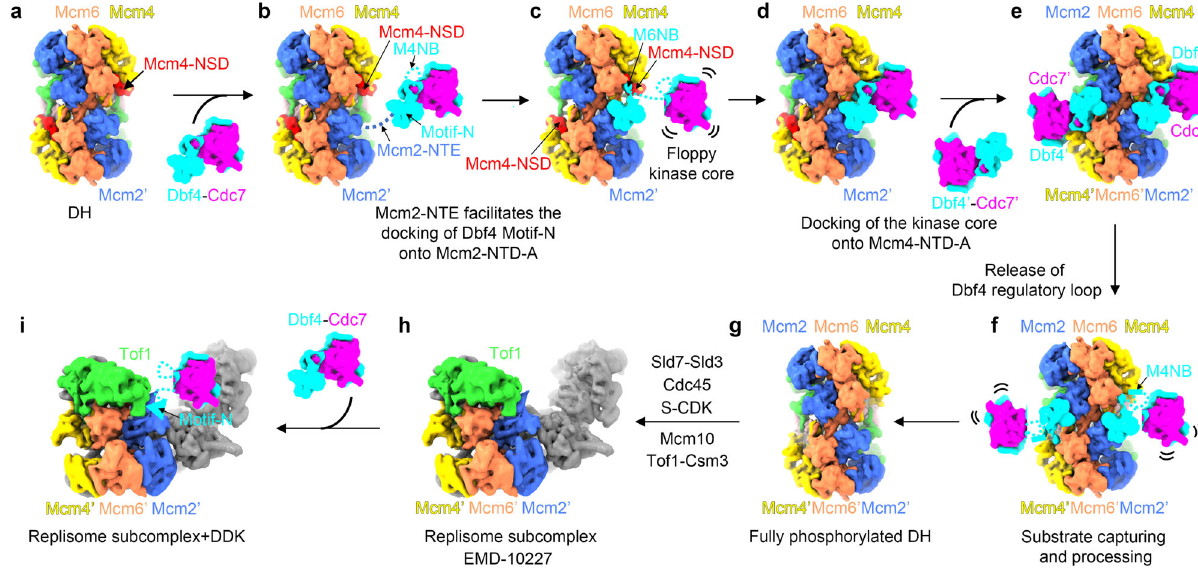
Fig. 6 Model illustrating the action of DDK on Mcm2-7 complex to regulate helicase activation and replisome activities. To summarize the high- resolution snapshots of the DH-DDK structures into a congruent series of motion frames that represent the step-by-step action of DDK on its MCM substrates. The low-pass fi ltered cryo-EM maps are used to depict DH, DDK, and replisome (EMD-10227). a Once assembled at replication origin, the DH encircles dsDNA with the NSD of Mcm4 nested on its own NTD-A to impose an inhibitory effect on helicase activation. b The unstructured NTE of Mcm2 ’ engages with motif N of Dbf4 and/or other region of DDK to facilitate the docking of motif N onto the NTD-A of Mcm2 ’ . c When motif N and M6NB of Dbf4 bind to the NTD-As of Mcm2 ’ and Mcm6 respectively, the fl oppy kinase core of DDK is positioned proximal to the NTD of Mcm4. d The kinase core is then docked onto the NTD-A of Mcm4 with the NSD of Mcm4 displaced by the M4NB of Dbf4 to be captured by Cdc7. During this docking process, the regulatory loop of Dbf4 occupies the activity center of the kinase to prevent premature substrate capturing by Cdc7. e DDK is docked onto each of the coupled MCM hexamers to function independently. f Conformational change in the kinase core and its subsequent dissociation from Mcm4 help to remove the regulatory loop of Dbf4 from Cdc7, enabling kinase center accessible to substrates. g After DDK phosphorylation, the NSD of Mcm4 becomes highly fl exible, and exposes potential binding surfaces for origin fi ring factors to convert the DH into two active replisomes. h In the replisome, the binding surfaces of Dbf4 on Mcm4 and Mcm6 are covered by Tof1, which effectively redirects the DDK docked on the NTD-A of Mcm2 to other substrates. Note: the “ replisome subcomplex ” (CMG-Ctf4-Csm3-Tof1, EMD-10227) only depicts part of the replisome. i The DDK, recruited to the NTD-A of Mcm2 located at the front end of the translocating replisome, can extend its fl exible kinase core to target substrates ahead of the replication